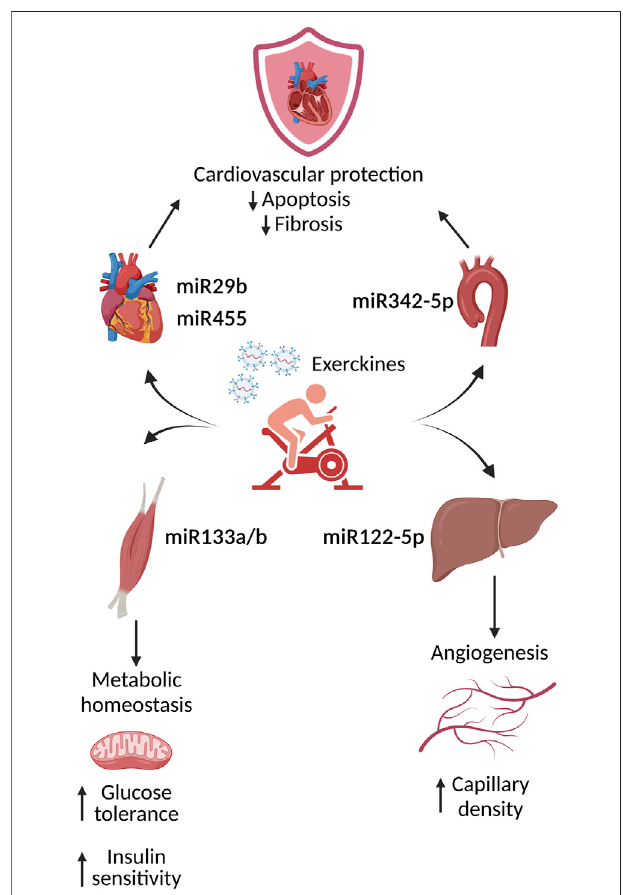
FIGURE 2 | Physiological effects of the induced exerkines upon exercise. During exercise, multiple organs release exosome containing factors,suchasmiRNA,calledexerkines.Thesemoleculesareabletoactivate intra-intercellular pathways leading to an amelioration and protection of the cardiovascular